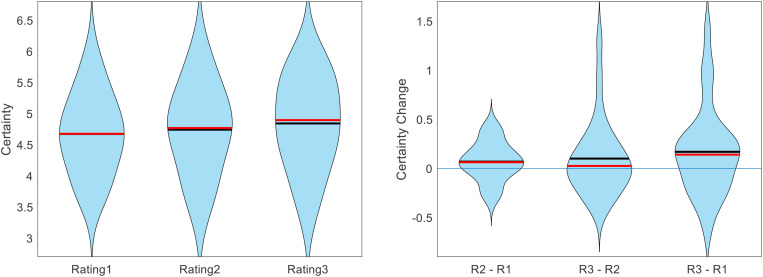
Across participants, value estimate certainty (across items) increased with each additional rating. Figure shows the cross-participant mean of within-participant mean certainty ratings across trials, separate for each rating task (black lines indicate means, red lines indicate medians).